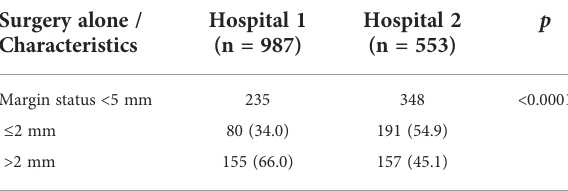
TABLE 6 Subgroup analysis of patients treated with surgery alone and margin status <5 mm: additional strati fi cation of margins ≤ 2 mm versus >2 mm.